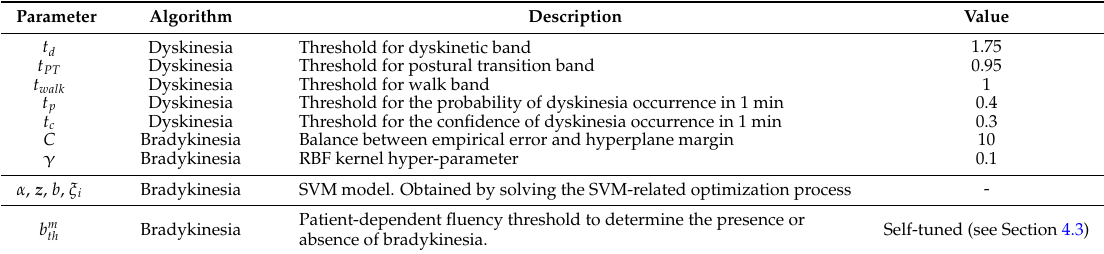
Table 3. Summary of the parameters used in this work.